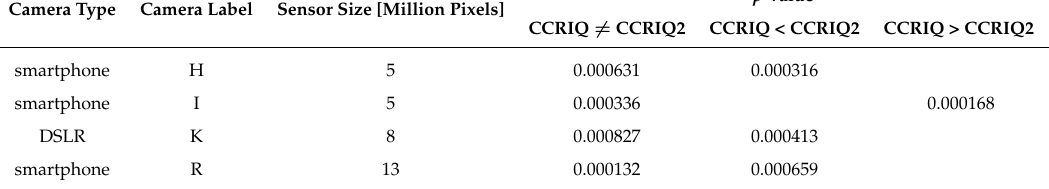
Table 2. Significant p -values of the two-sided (fourth column) and the one-sided (fifth and sixth columns) U tests. The tests compare the new CCRIQ2 and legacy CCRIQ data sets. We group individual scores by a camera type. Then, we apply U test for pairs of groups (one group of scores in the pair comes from CCRIQ and one from CCRIQ2). The third column presents sensor sizes of each camera. We show them to verify the hypothesis of low resolution images being similarly scored in both data